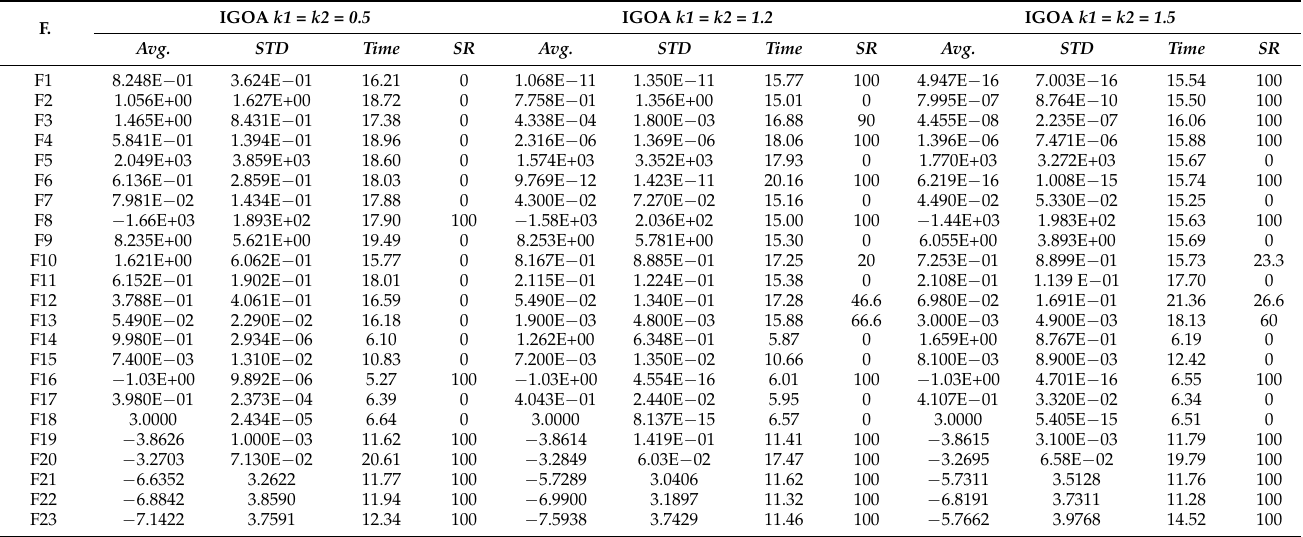
Table 2. Comparison between the IGOAs of different parameters.